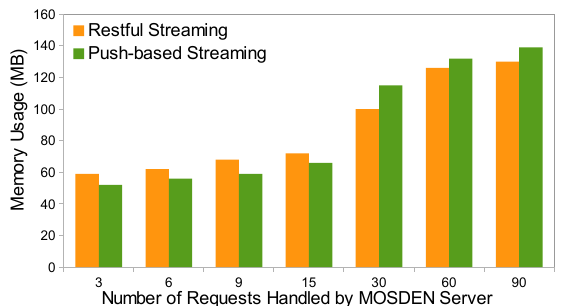
Figure 13. Comparison of Memory Usage by MOSDEN